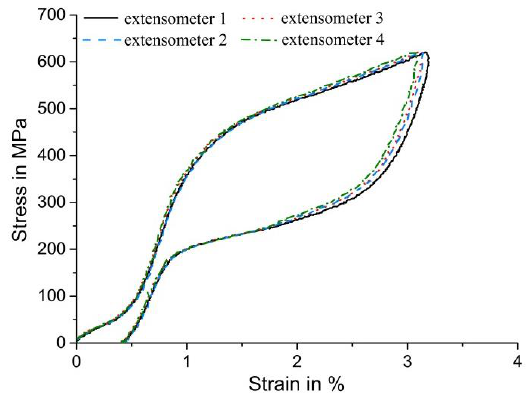
Figure 8. Nominal/axial engineering stress–strain curves determined under compression-shear loading. Various positions of virtual extensometers (shown in Figure 7a) result in a small but systematic effect on the resulting stress–strain curves. Larger gauge lengths are associated with larger total strain values, because they put more relative weight on the regions that exhibit the largest strains.